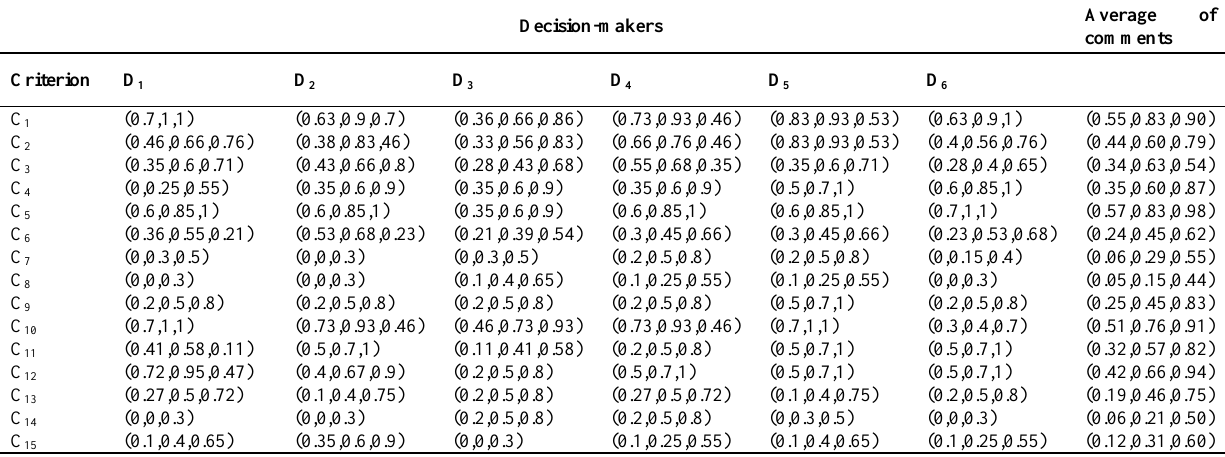
Table 6. Importance weight of each criterion based on requirements of organization.